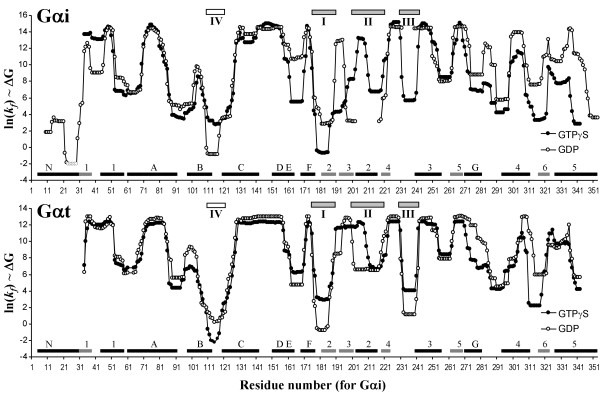
Distribution of local folding free energies over the residues of Gαi or Gαt. Free energies are given as ln(kf) in the GDP or GTPγS bound forms of the proteins as indicated. Secondary structure elements are indicated as strips next to the x-axis (black for helices, grey for β-sheets) and named according to the convention given in figure 1. Known switch regions are also shown as grey strips numbered form I to IV on top of each picture. The two sequences are aligned and Swiss Prot residue numbering for Gαi is used in both cases.